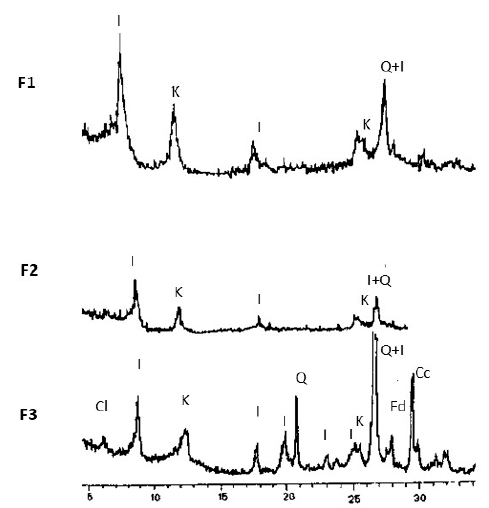
Figure 2. XRD diagrams for each particle size fraction: F1, F2, and F3 (from top to bottom, respectively. Legend: Q: quartz; I: Illite; K: kaolinite; Cl: chlorite; Fd: feldspar; Cc: calcite. Table 3. Main elements (wt%). LOI: Loss on ignition. Table 2. Mineralogical composition of clay fractions (%kaolinite, %illite/muscovite). Mean value of the 60 samples analyzed, and ranges for each series (40 OE samples and 20 AA samples).